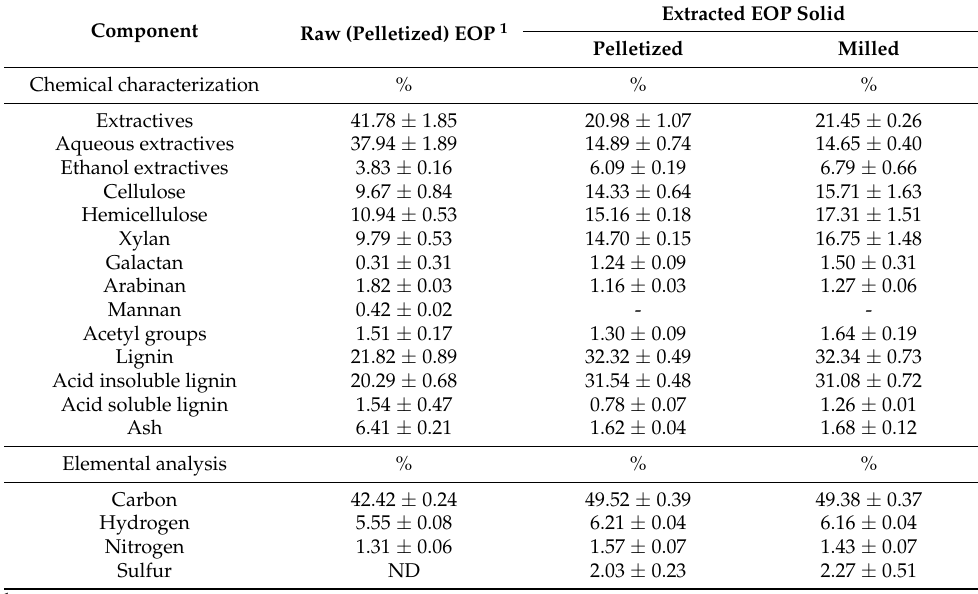
Table 5. Chemical and elemental composition (%, dry weight basis) of pelletized and milled ex- hausted olive pomace (EOP) after ultrasound-assisted water extraction under optimal conditions: 80% amplitude, 16 min, 11.5% ( w / v ) solid loading. Data represent the mean value ± standard deviation ( n =